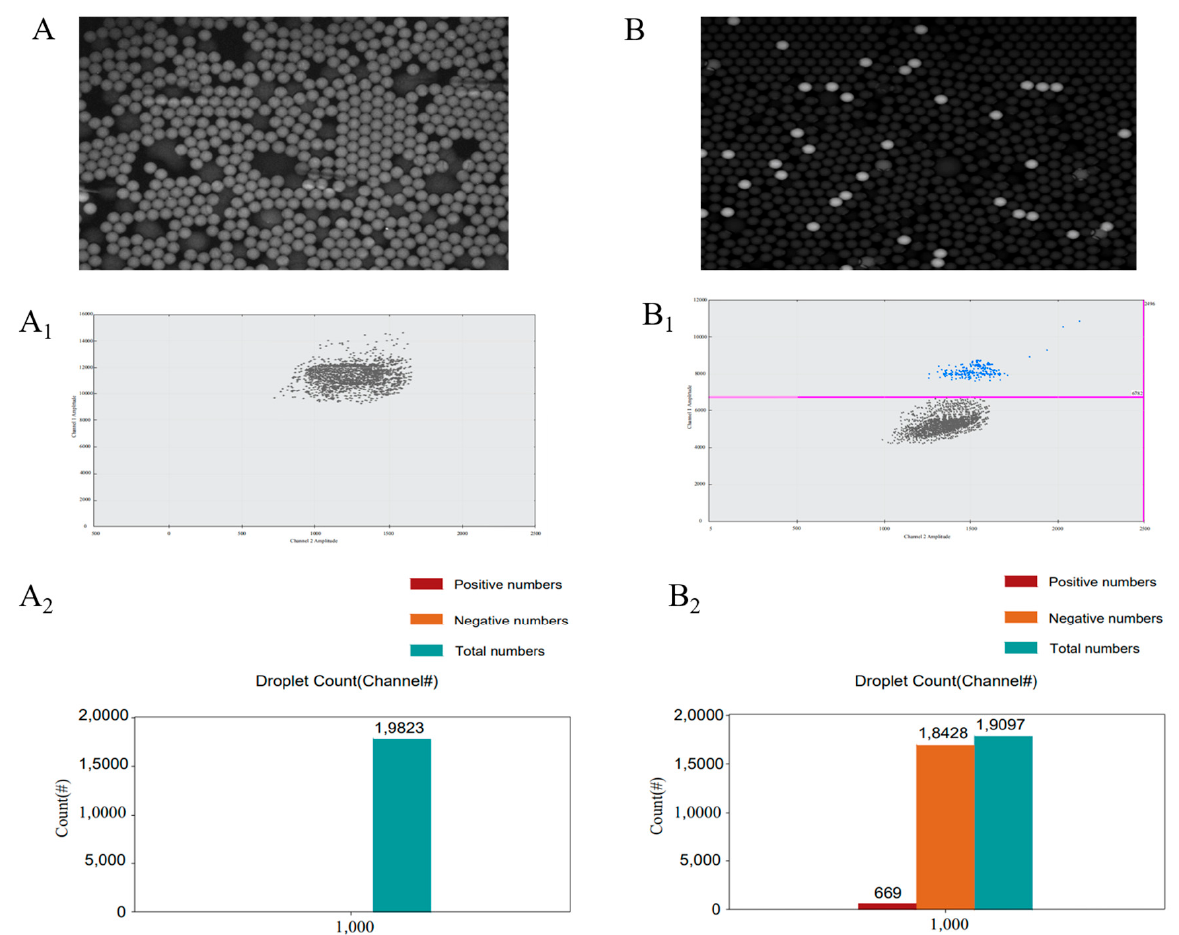
Figure 3. ( A ) RT-LAMP-BART bioluminescent droplet images prepared using a conventional BART reagent mixture [17]. ( A 1 ) The distribution of bioluminescent counts in ( A ). ( A 2 ) Droplet count classifications in ( A ). ( B )